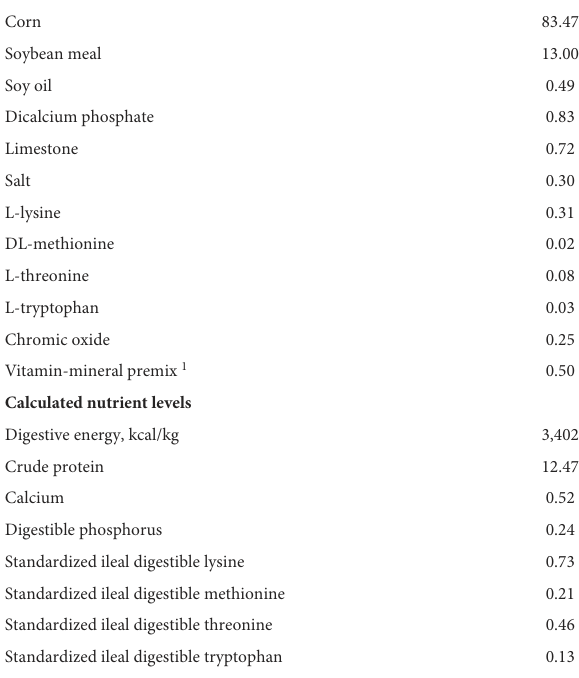
TABLE 1 Composition and nutrient levels of basal diets (%, as-fed